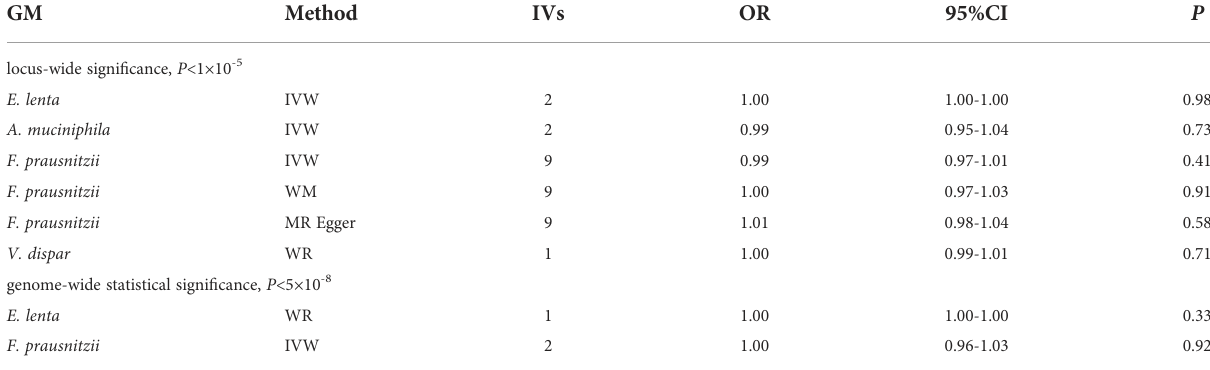
TABLE 2 MR results between GM at the species level and